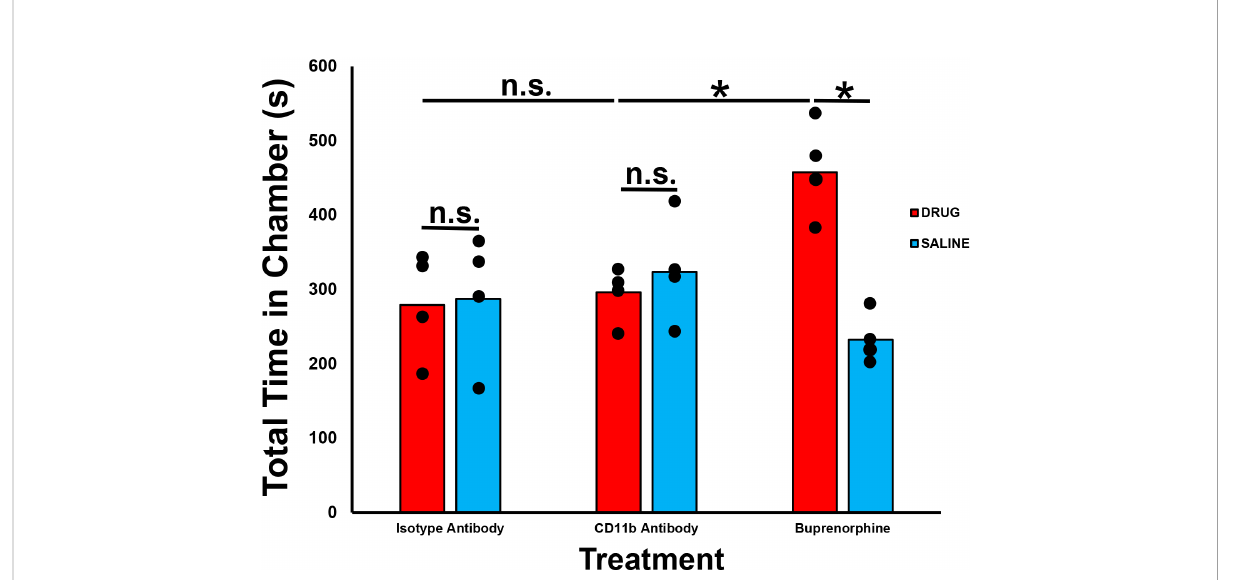
FIGURE 8 Effect of CD11b administration on drug reward behaviors in healthy adult mice. Bar histograms demonstrating mean total chamber time spent from a representative conditioned place preference test following systemic CD11b blockade are shown. Chamber preference is not seen following CD11b monoclonal antibody administration in adult SJL/J mice relative to saline administration in contrast to signi fi cant chamber preference based on total time spent in the drug administered chamber seen following Buprenorphine administration (positive control). Isotype antibody-treated mice serve as a negative chamber preference control. *p < 0.05. n.s. not signi fi cant, N =